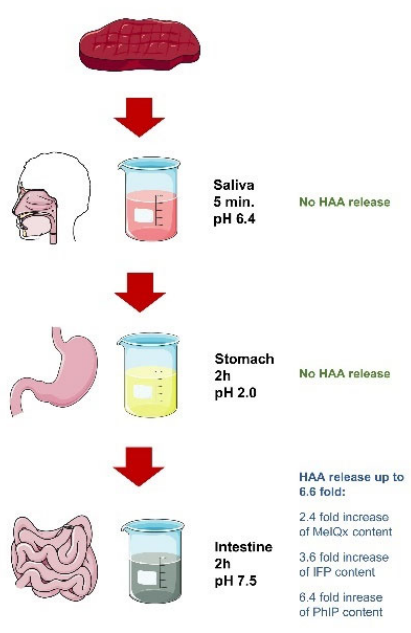
Figure 2. Release of HAAs at each stage of the artificial digestion tract.